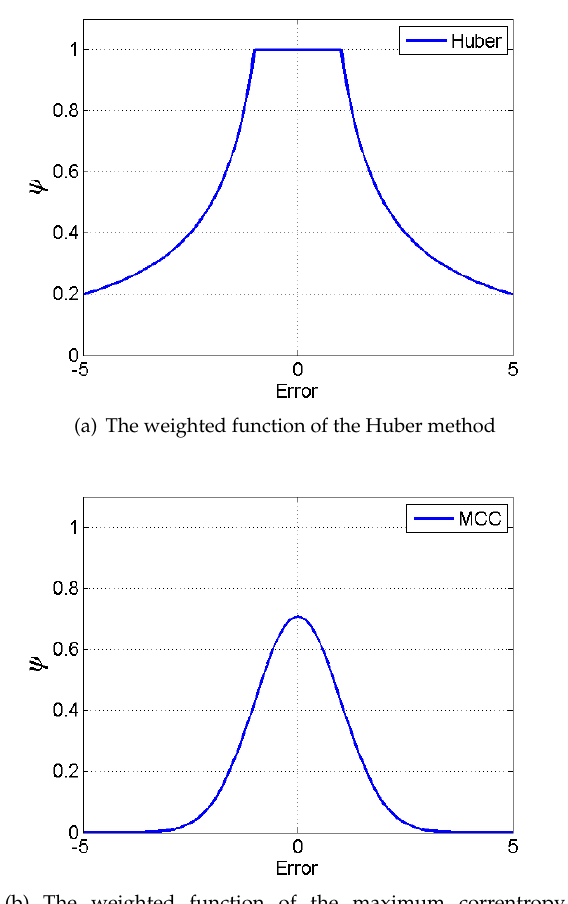
Figure 4. The weight comparison with the error growth of two methods where λ = δ =